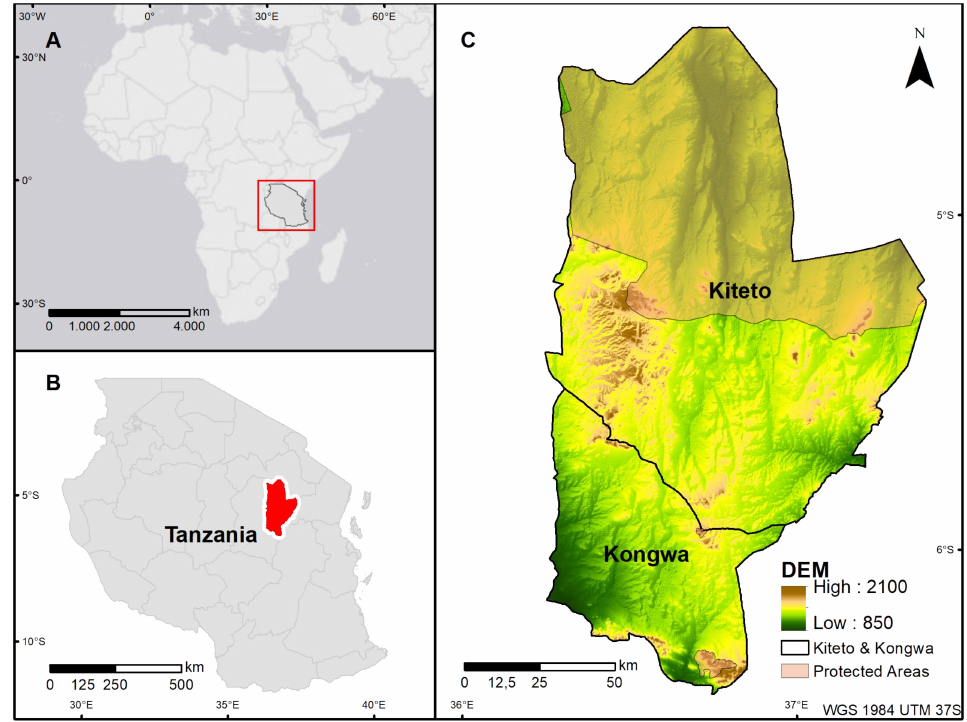
Figure 1. Location of the study area in Central Tanzania ( A , B ) and protected areas ( C